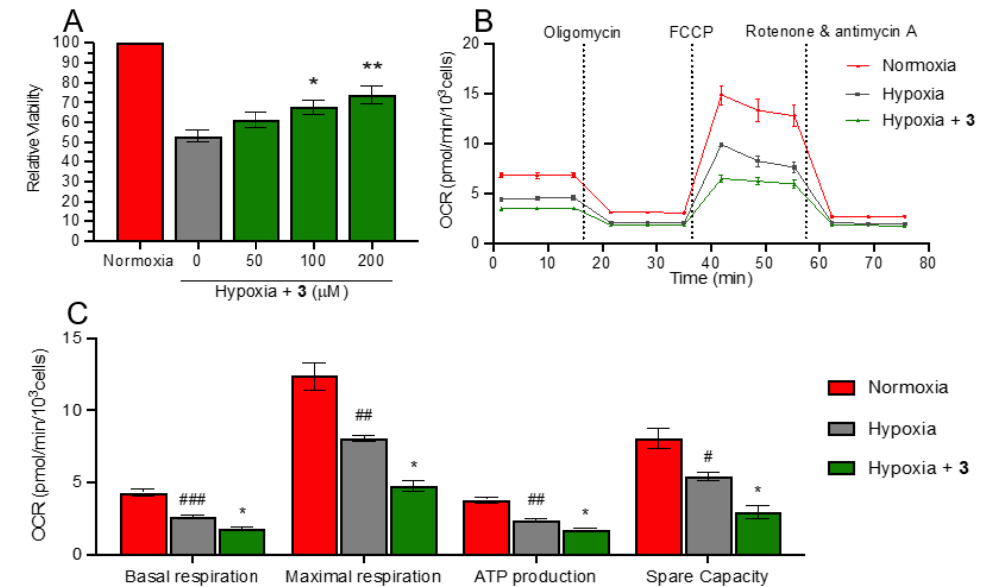
Figure 4. Effect of RSSH donor 3 on H9c2 cells during reoxyenation following hypoxia. ( A ) Dose- dependent protection of cell viability by compound 3 against 24 h of hypoxia followed by 3 h reoxygenation (n=3) * p , 0.05, ** p , 0.005 vs. normoxic controls. ( B ) OCR of H9c2 cells under normoxia, or 24 h hypoxia followed by reoxygenation with or without precursor 3 . ( C ) Mitochondrial function parameters calculated from respiration data in (B) (n=3) # p , 0.05, ## p , 0.005, ### p , 0.001 vs. normoxia control; * p , 0.05 vs. hypoxia group.